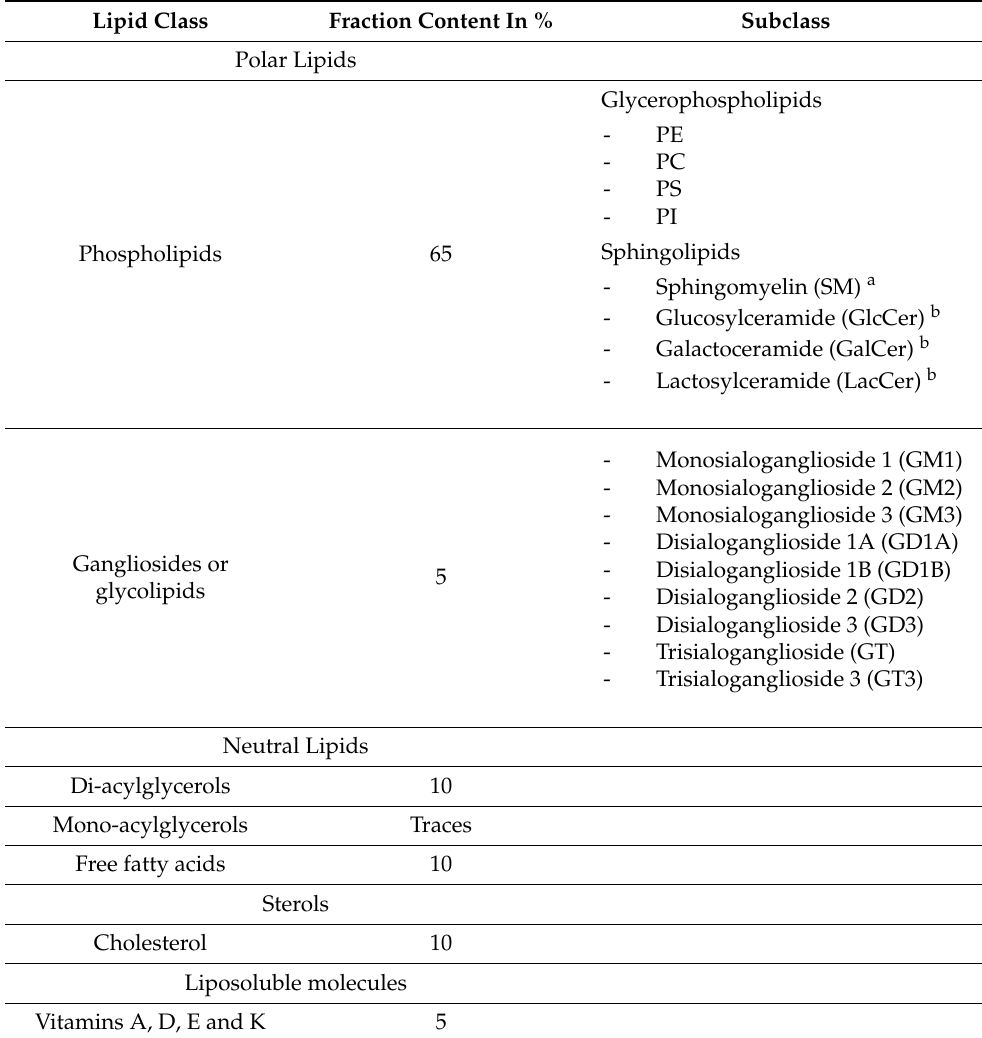
Table 2. Composition of the MFGM lipids. Data compiled from